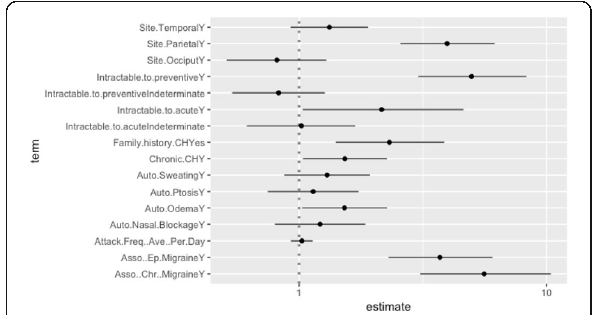
Fig. 1 (abstract P34). Estimate odds-ratio of each selected item entered into the logistic regression model